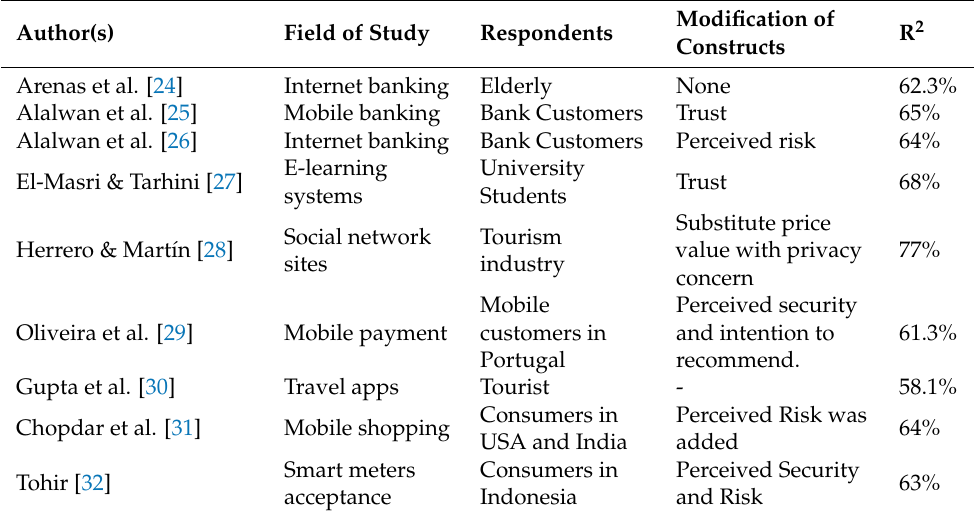
Table 1. Applications of UTAUT2 in different